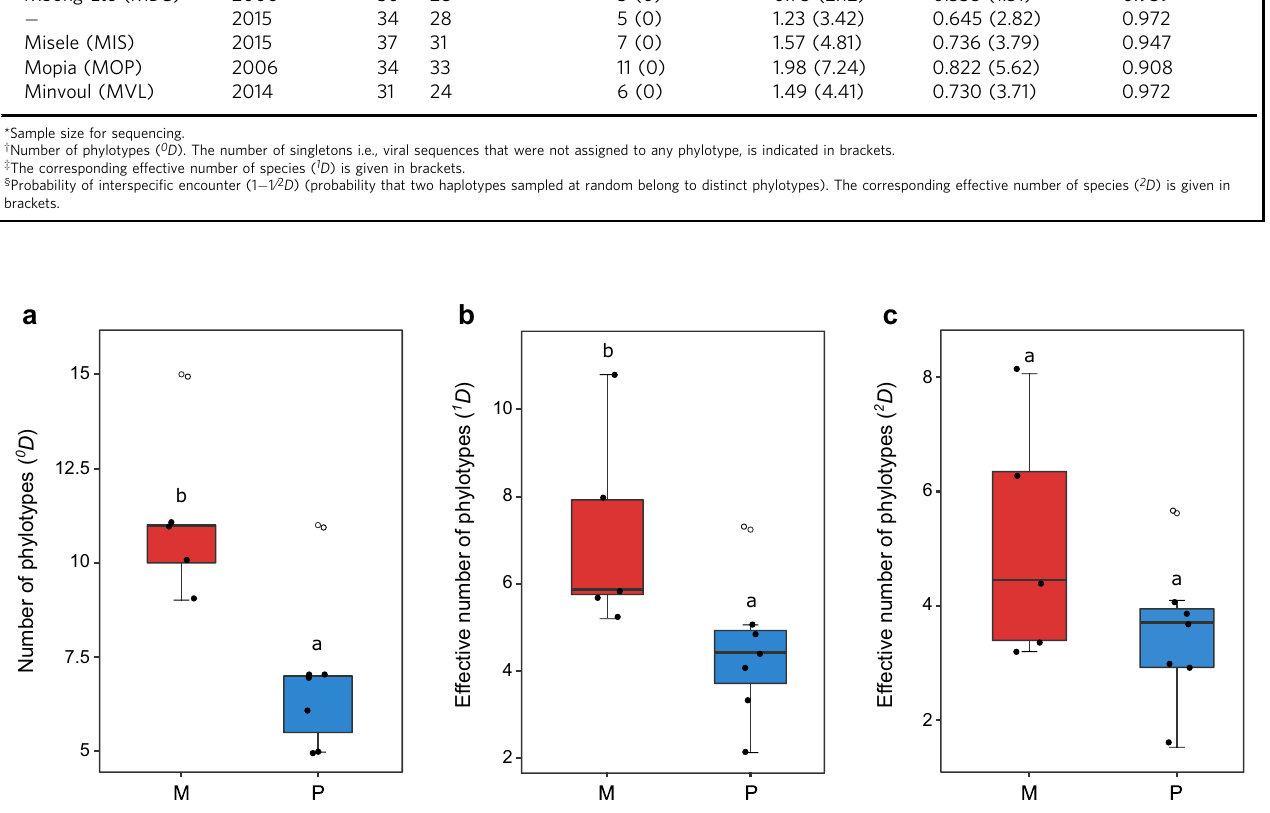
Fig. 3 Differences in mean levels of phylogenetic diversity between ( n = 5) matrilineal villages (M, red) and ( n = 7) patrilineal villages (P, blue). Villages from the eastern cluster with mixed kinship systems (IMB, MOP) were assimilated to patrilineal societies (details in Supplementary Data 1). The composition of viral assemblages is based on the distribution of viral haplotypes among the 29 phylotypes. a Diversity based on the number of phylotypes ( 0 D ). b Effective diversity based on Shannon entropy ( 1 D ). c Effective diversity based on Gini-Simpson index ( 2 D ). Box plots indicate the median (middle line), 25th and 75th percentile (box) and 5th and 95th percentile (whiskers) as well as outliers (open